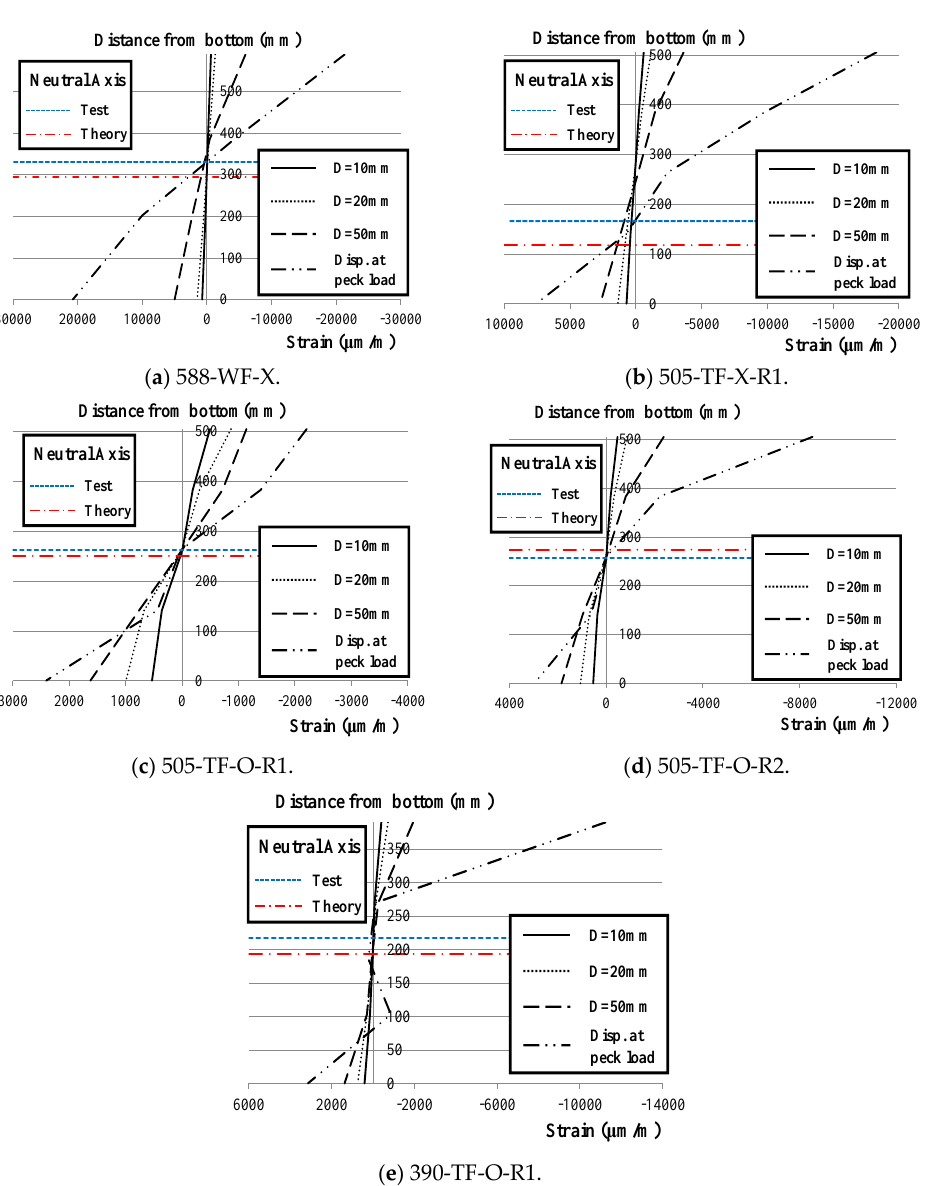
Figure 14. Measured strain distributions of the non-composite specimens. Table 11. Locations of neutral axis at failure of the non-composite specimens.